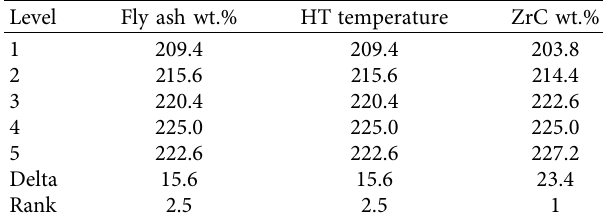
Table 6: Mean response for